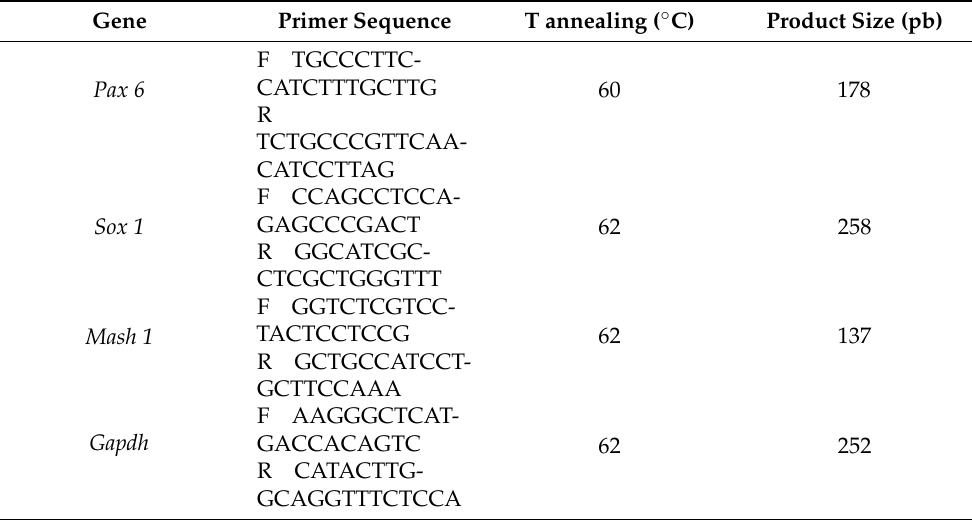
Table 1. Primer sequences for target and reference genes used in qRT-PCR assays; F = forward primer (5 (cid:48) –3 (cid:48) ), R = reverse primer (3 (cid:48) –5 (cid:48) ). Gene Primer Sequence T annealing ( ◦ C) Product Size (pb) F Pax 6